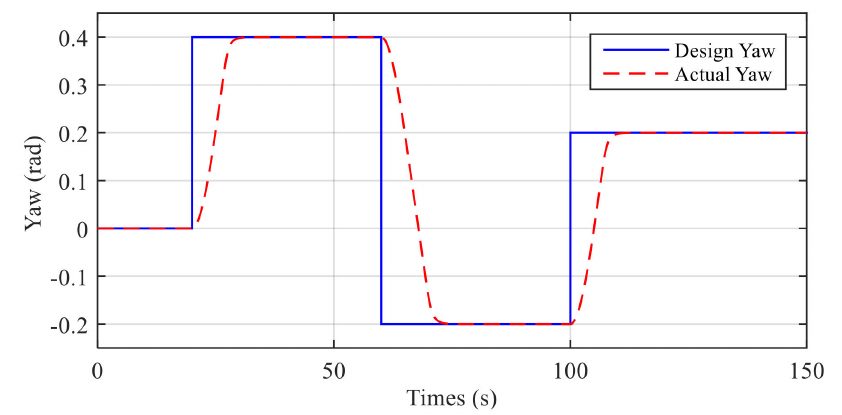
Figure 9. The yaw attitude of the MJ-AUV.